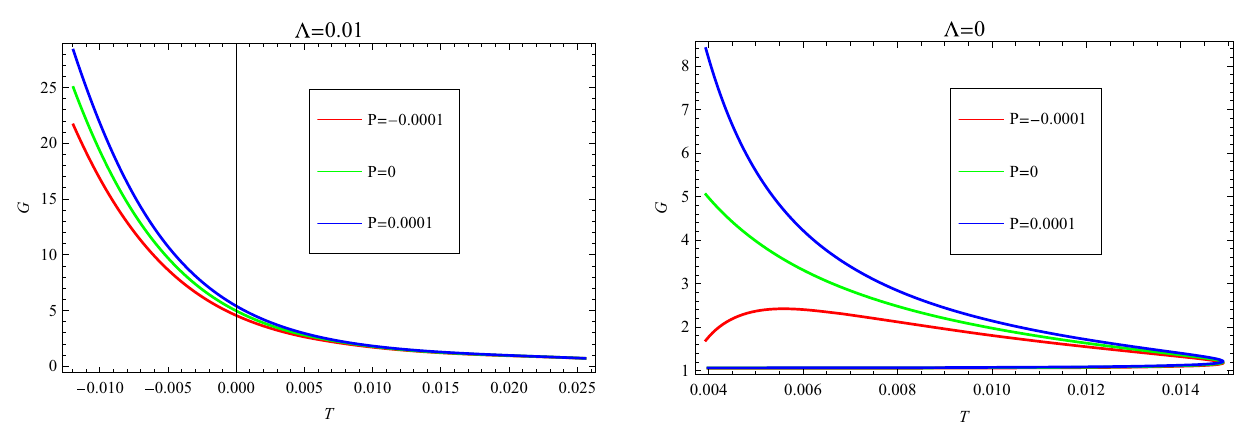
Fig. 5 Plot of Gibbs free energy versus temperature for first case when (cid:2) = 0 . 01 , Q = 1 of the non-minimal MCRBH m